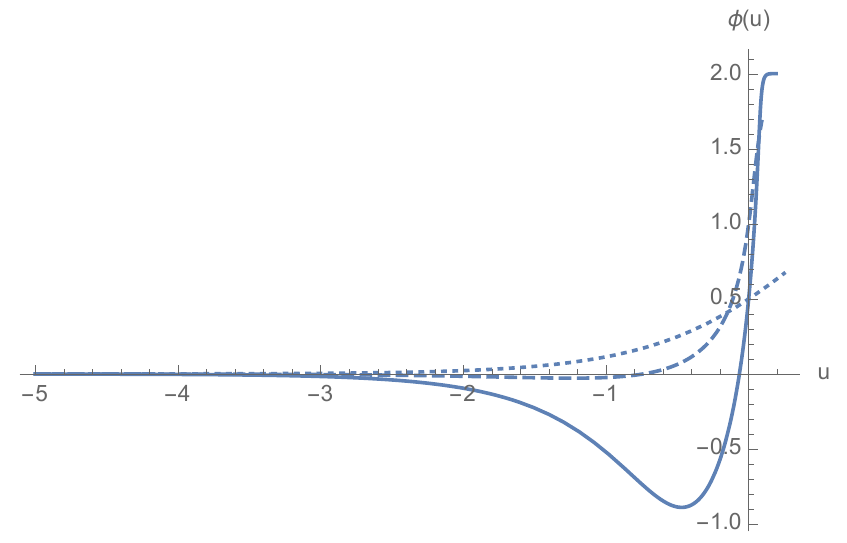
Figure 20 . Comparison of the vacuum solution (solid), a bouncing (cid:12)nite T solution with (cid:30) h = 1 : 7 (dashed) and a non-bouncing (cid:12)nite T solution with (cid:30) h = 0 : 7 (dotted) that arise from the potential shown in (cid:12)gure